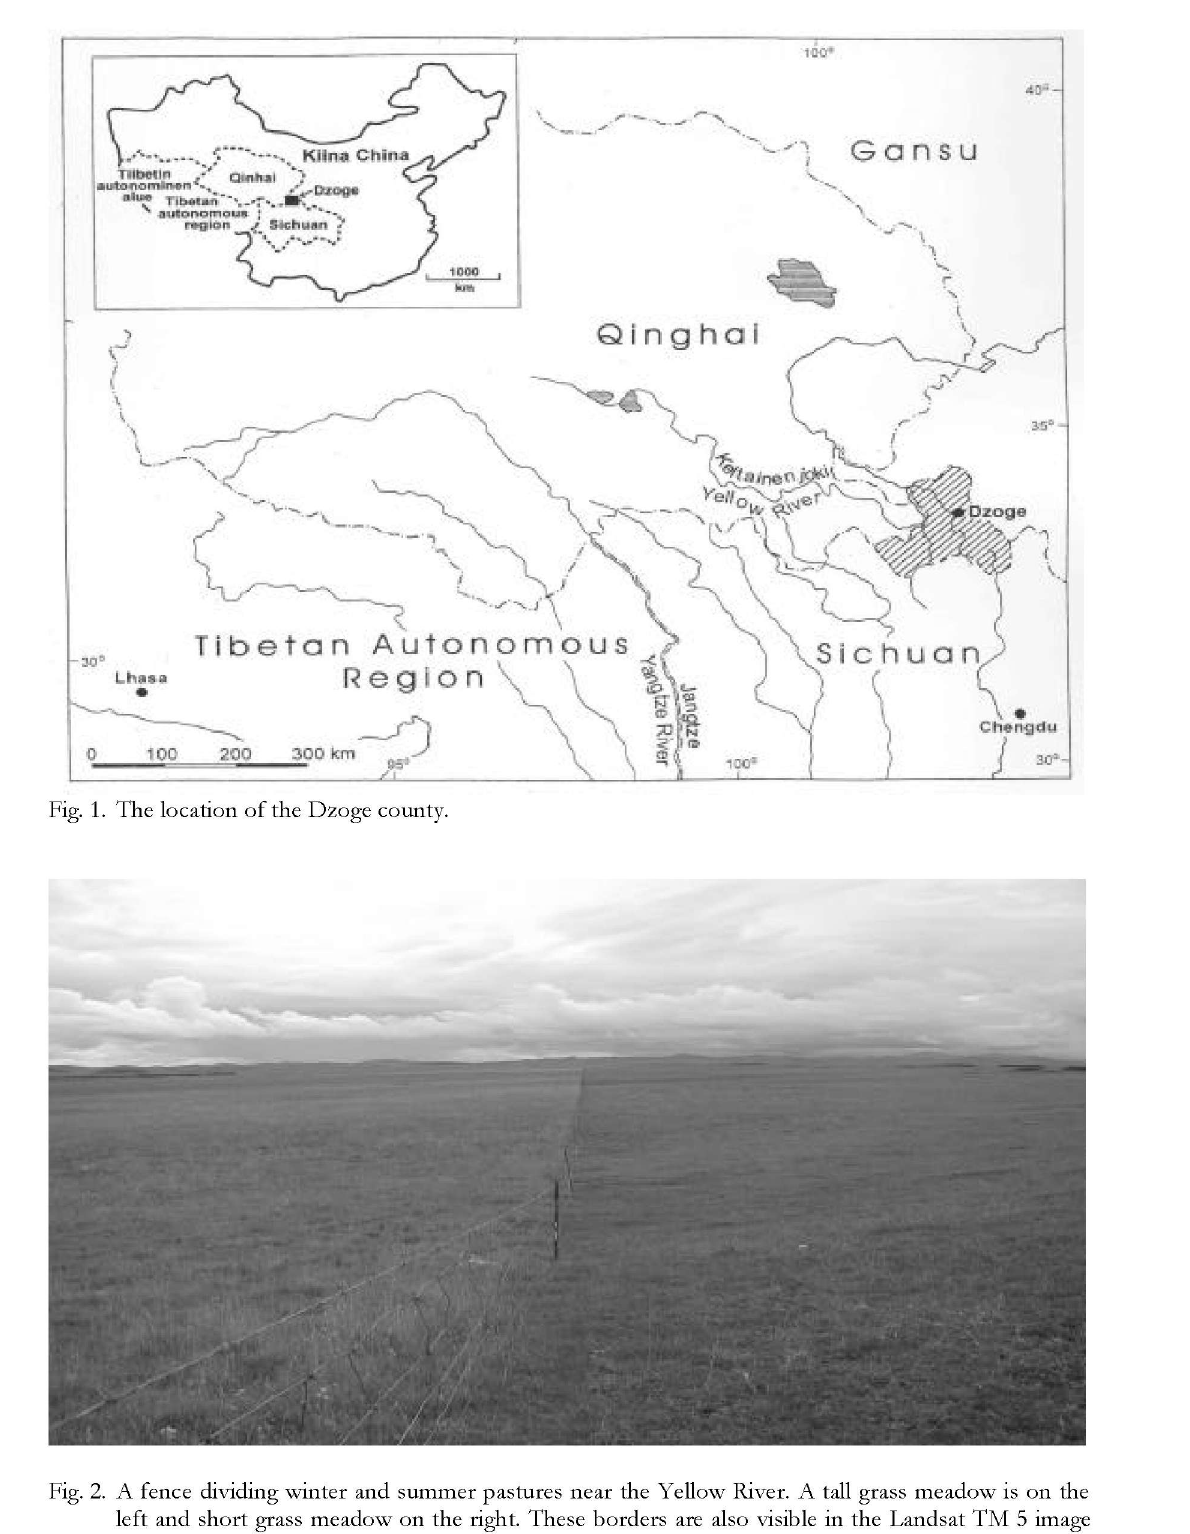
Fig. 2. A fence dividing winter and summer pastures near the Yellow River. A tall grass meadow is on the left and short grass meadow on the right. These borders are also visible in the Landsat TM 5 image (see Fig.